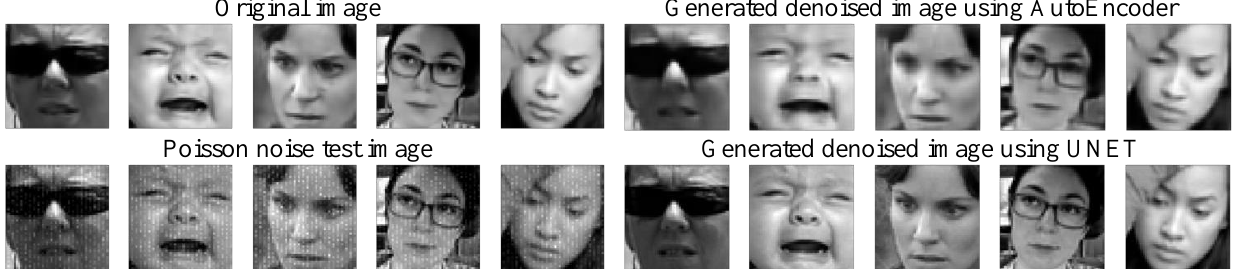
Figure 8. FER2013 images (a) original image (b) poisson noise image with noise factor of 0.05 (c) denoised